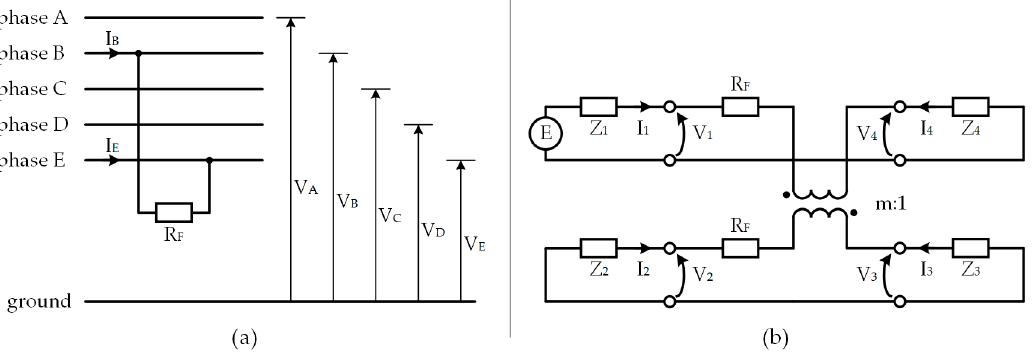
Figure 2. BE fault: ( a ) the five-phase system and ( b ) sequence networks connections. As seen in Figure 2b, I 1 and I 4 , and I 2 and I 3 , are the primary and the secondary winding currents of an ideal transformer, respectively, with a turns-ratio of m:1 (m with I 1 in opposition to I 4 , and I 2 in opposition to I 3 . The polarity of this ideal transformer, indicated in Figure 2b using a dot convention, ensures that all the constraints given in (16) are met by the depicted sequence networks diagram for a five-phase system under a BE